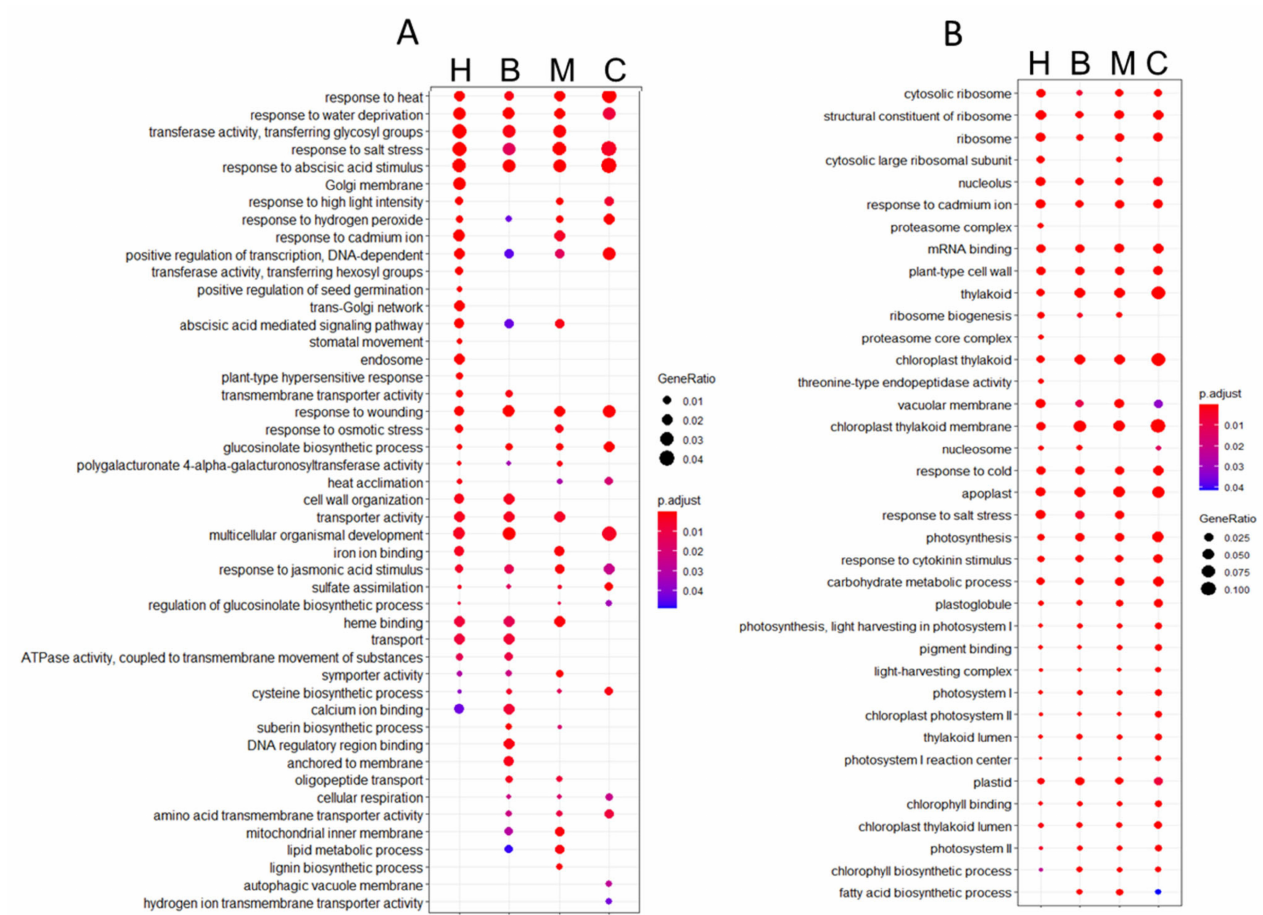
Figure 3. Gene set enrichment (GSEA) analysis of DEGs in Col-0 seeds under severe heat stress. ( A ) Functional enriched GO terms from upregulated differentially expressed genes. ( B ) Functional enriched GO terms from downregulated DEGs. The size of the dot represents the gene count. The totality of differentially up- or downregulated genes in each stage was used to perform a hypergeometric test, and the p -values were converted to false discovery rate (FDR)-corrected p -value as shown in colors, the red color being more significant than the blue color. H = heart, B = bent, M = mature, and C = common to all